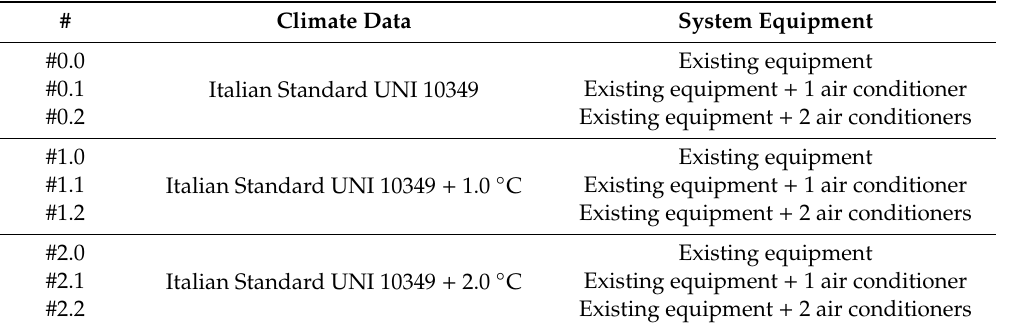
Table 1. Simulated